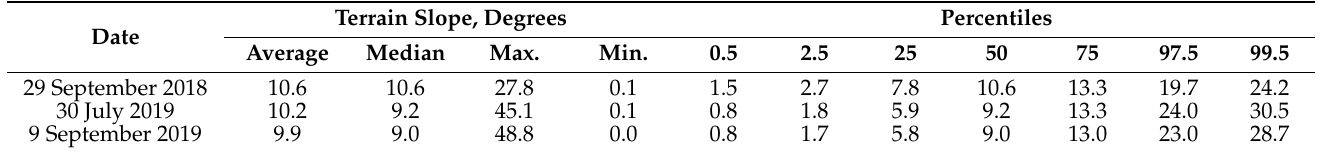
Table 4. Statistical indicators of the distribution of damaged forest stands by terrain slope.